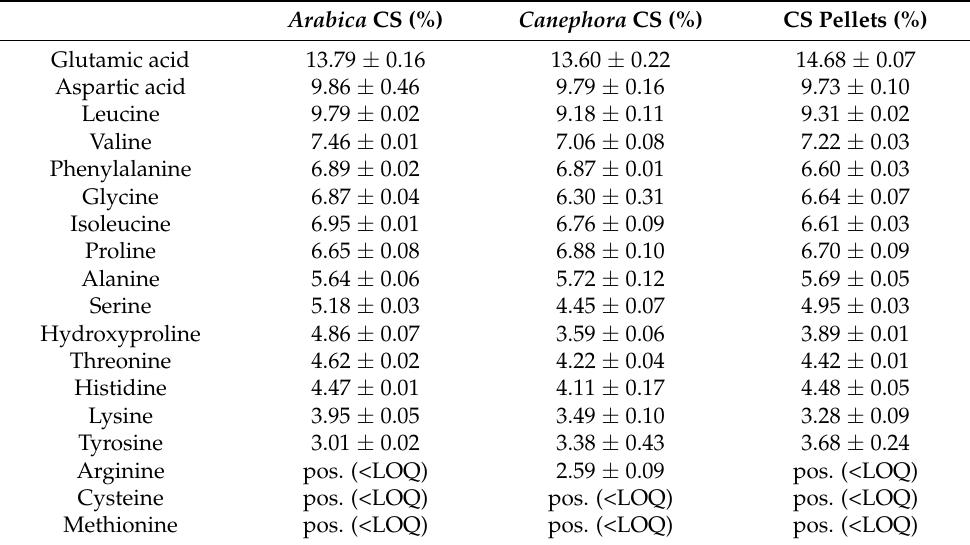
Table 4. Amino acid composition of proteins from coffee silver skin from Coffea arabica ( arabica CS) and Coffea canephora ( canephora CS) as well as coffee silver skin pellets (CS pellets); percent of total amino